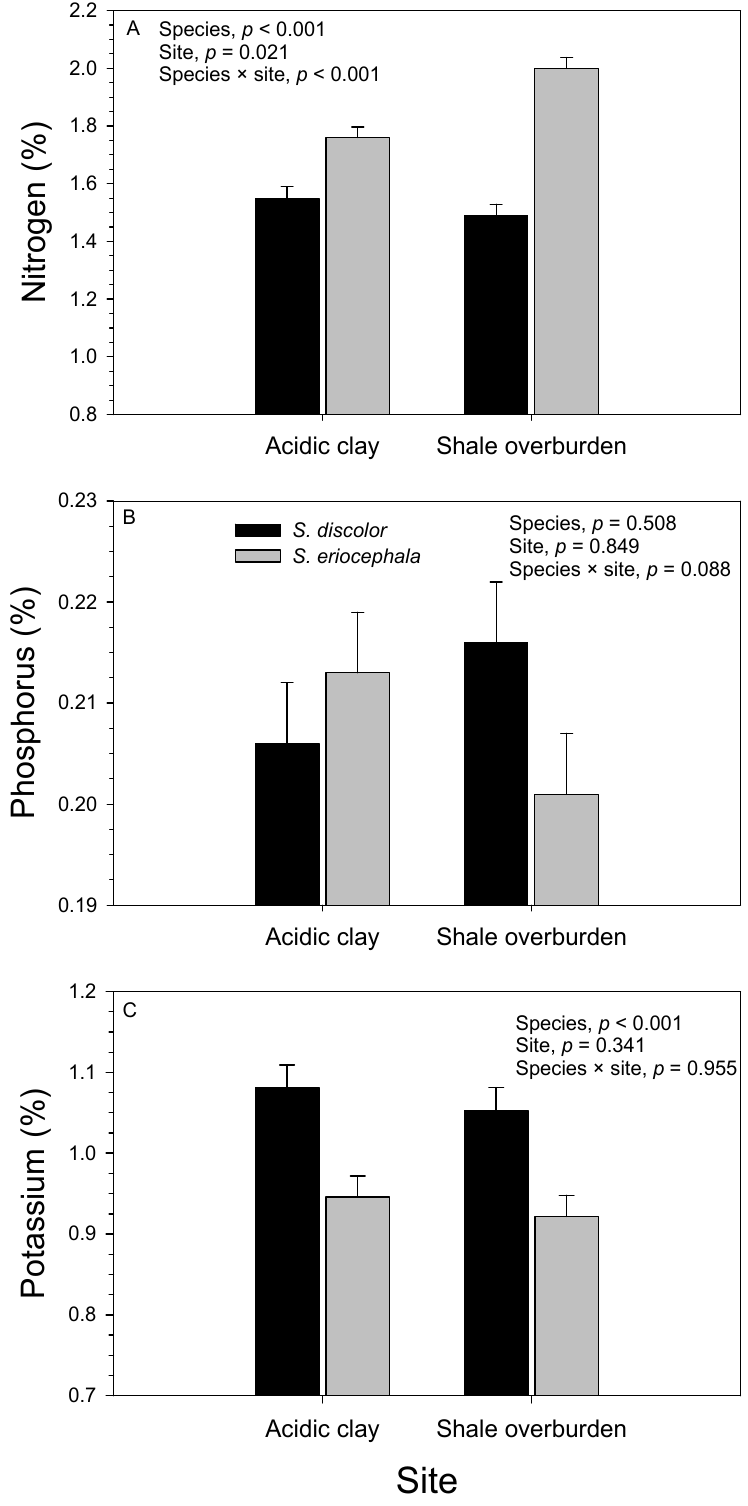
Figure 3. Foliar ( a ) nitrogen, ( b ) phosphorus, and ( c ) potassium concentrations (mean ± SE) of Salix discolor and S. eriocephala on acidic clay and shale overburden sites.